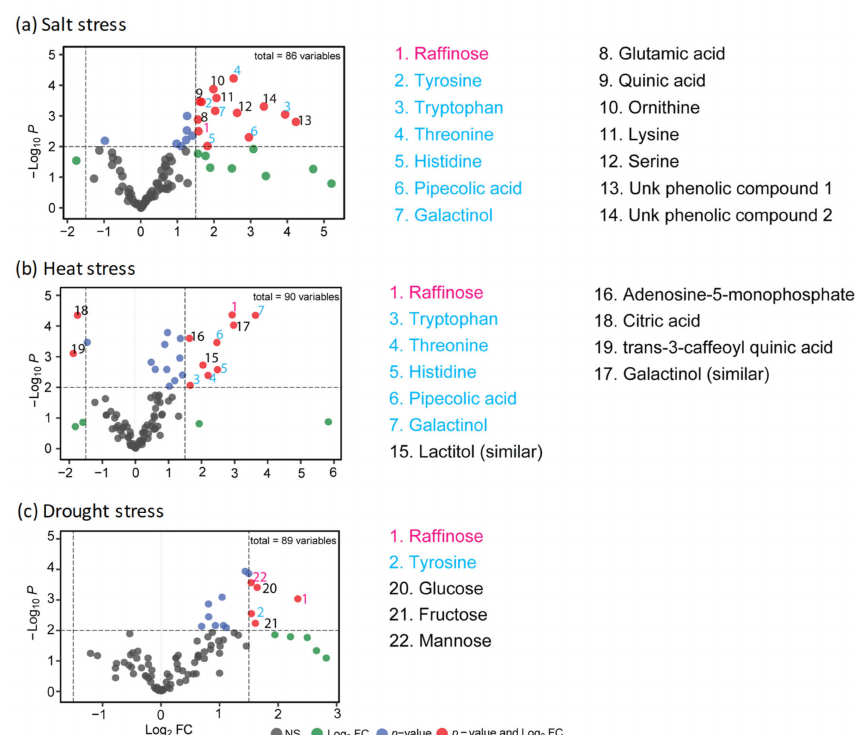
Figure 1. Enhanced volcano plots showing significantly changed metabolites in ( a ) salt stress, ( b ) heat stress, and ( c ) drought stress conditions. Volcano plots are represented with Log 2 fold change (FC) on x -axis and − Log 10 p -value on the y -axis. Each point represents a different metabolite. Circle colors indicate classification of metabolites based on Log 2 FC absolute value using a cutoff of 1.5-fold and by statistical significance ( p ≤ 0.01, − log 10 p ≥ 2.0). Gray circles, Log 2 FC absolute value ≤ 1.5 and − log 10 p < 2.0; green circles, Log 2 FC absolute value >1.5 and − log 10 p ≥ 2.0; dark blue circles, Log 2 FC absolute value ≤ 1.5 and − log 10 p < 2.0; red circles, Log 2 FC absolute value >1.5 and − log ≥ 2.0. In total, 22 metabolites met the threshold for significance Log 10 p 2 FC values (absolute value ≥ 1.5, p ≤ 0.01). Text colors of metabolite names indicate overlap among treatments. Magenta, metabolites with significant Log 2 FC in all three stress treatments; sky blue, significant Log 2 FC in at least two treatments; black, significant Log 2 FC in one